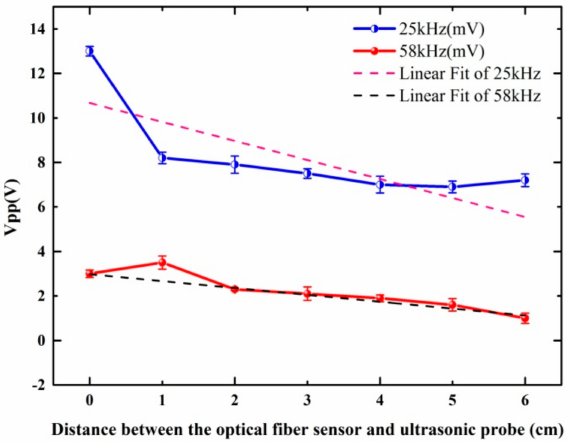
Figure 7. V pp with the variation of distance in the 25 kHz and 58 kHz ultrasonic